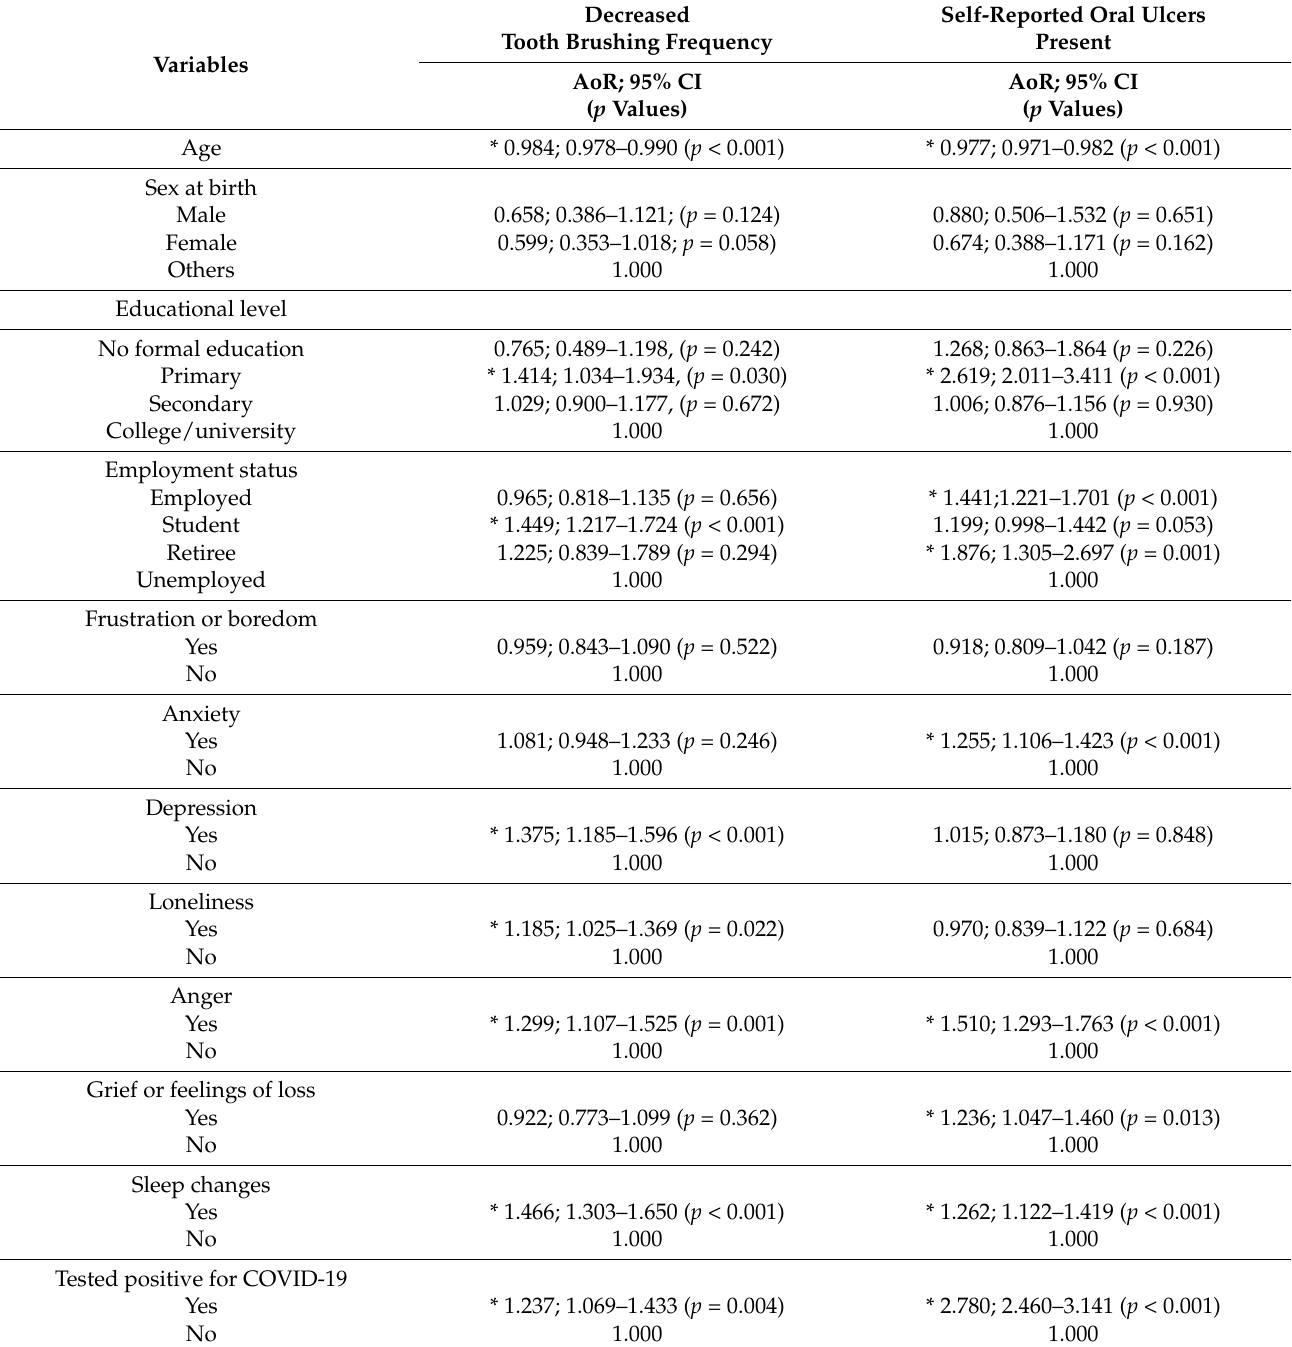
Table 2. The binary logistic regression analysis determines the risk indicators for the decreased frequency of tooth brushing and the presence of self-reported oral ulcers during the first wave of COVID-19 in 152 countries (N =